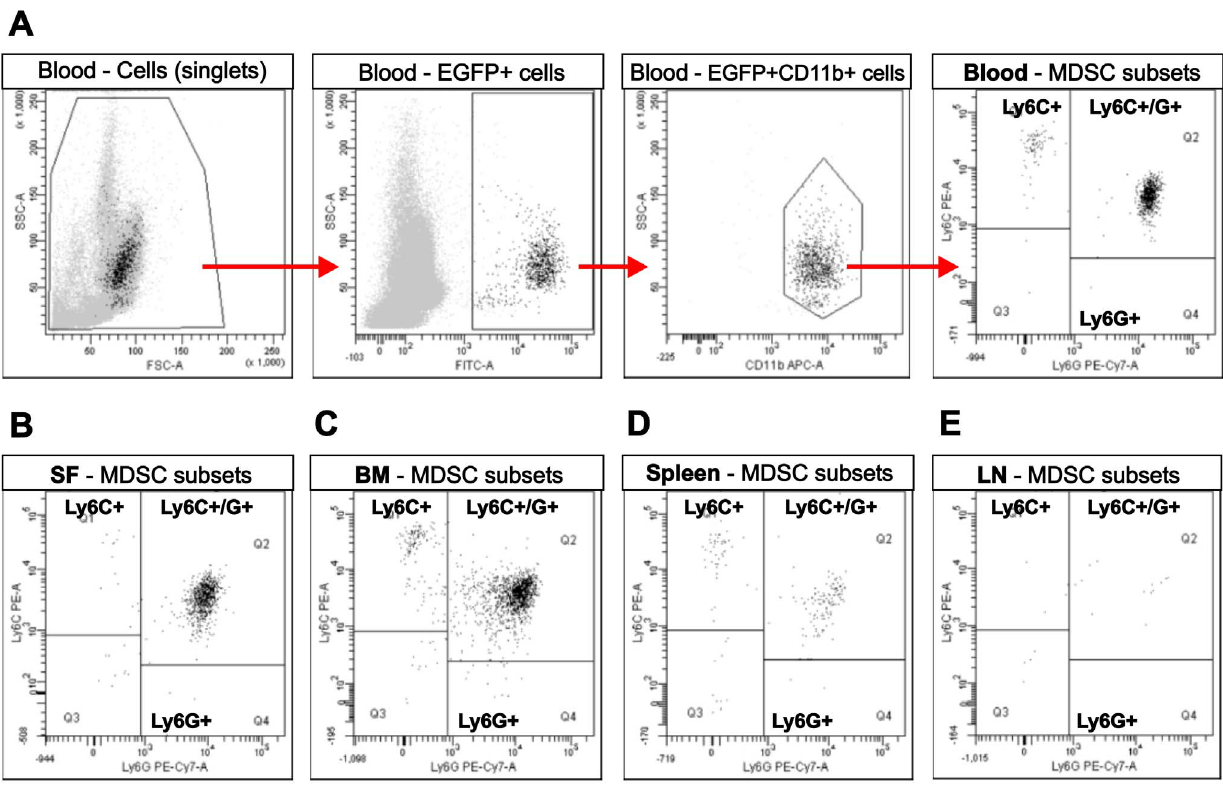
Figure 6. Tissue distribution of EGFP BM-MDSCs injected into SCID mice with adoptively transferred PGIA. BM-MDSCs, generated + from EGFP-LysM-Tg mice (expressing EGFP in myeloid cells only) were co-injected with arthritic spleen cells into SCID mice at the early phase of adoptively transferred PGIA, as described in the Methods. To assess the tissue distribution of fluorescent donor cells, 19 days after the co-transfer of the cells ( A ) peripheral blood, ( B ) synovial fluid (SF), ( C ) BM, ( D ) spleen, and ( E ) joint-draining lymph nodes (LN) were harvested from the SCID recipients, immunostained, and subjected to flow cytometry. The gating strategy, as demonstrated on the blood cells (top panels), involved gating first on single cells, then on EGFP cells, followed by gating on the CD11b myeloid population (red arrows). Subset composition of + + EGFP CD11b cells was determined on the basis of Ly6C and Ly6G expression. Peripheral blood, SF, and BM contained very well detectable + + populations of Ly6C Ly6G (granulocytic) cells and much smaller populations of Ly6C Ly6G (monocytic) cells. Cells belonging to either subset int hi hi 2 were less frequent in the spleen, and nearly undetectable in the LNs. Representative flow cytometry dot plots of cells from 1 of 3 mice (except for SF, which was pooled from all of the 3 mice) are shown.